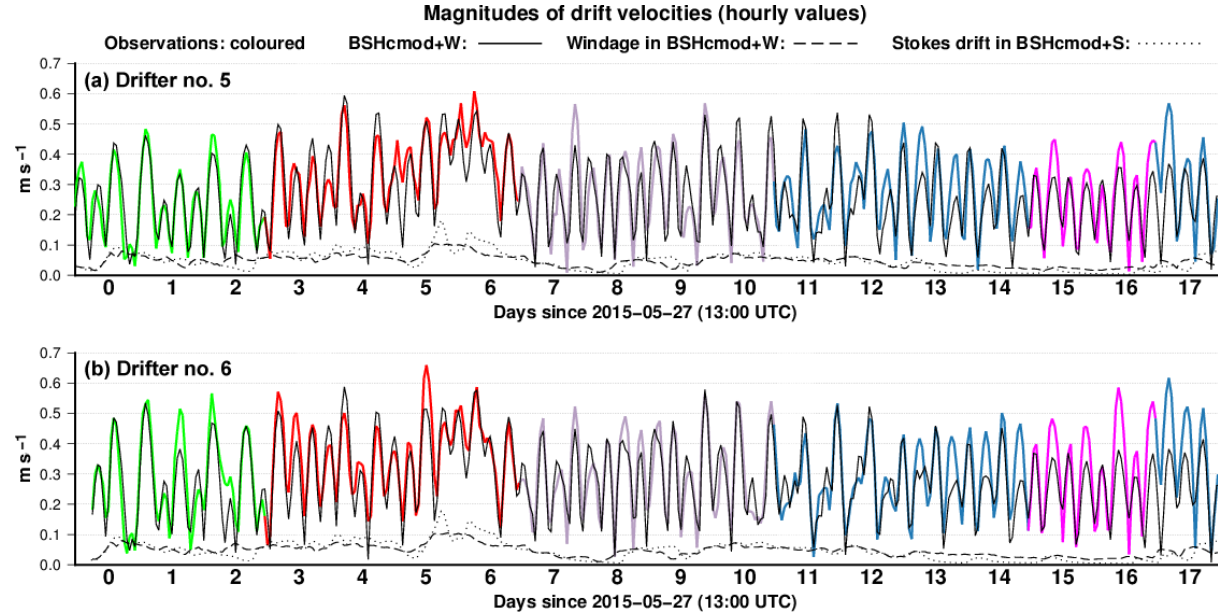
Figure 12. Magnitudes of drift velocities on an hourly basis, considering drifter nos. 5 (a) and 6 (b) . As in Fig. 6, magnitudes of observed velocity vectors (coloured) are compared with simulations based on BSHcmod + W. In addition, magnitudes of windage (in BSHcmod + W) and Stokes drift (in BSHcmod + S) are shown. All model values are specified from either atmospheric or marine fields interpolated to observed (not simulated) drifter locations. For full time series, see the Supplement